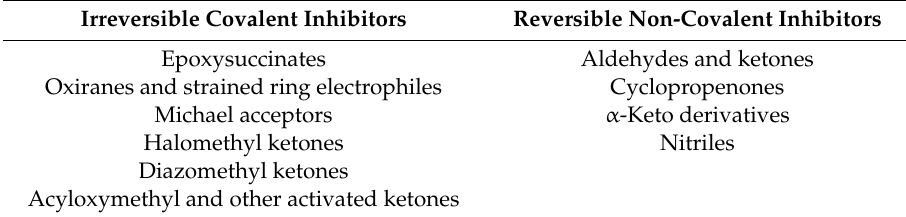
Table 4. Inhibitors of